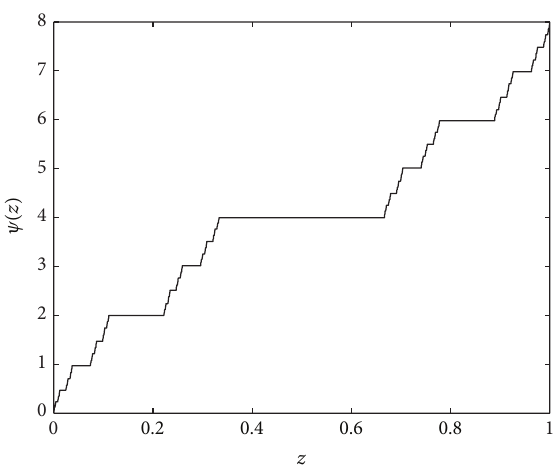
Figure 1: Plot of (31) with parameters 𝛼 = ln 2/ ln 3 and 𝑏 = 1 .